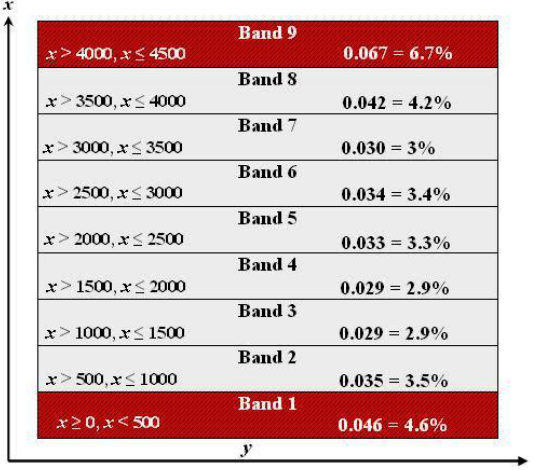
Figure 4. Configuration of nursery for the calibration process; values for x ( left ) and percentage of diseased saplings ( right